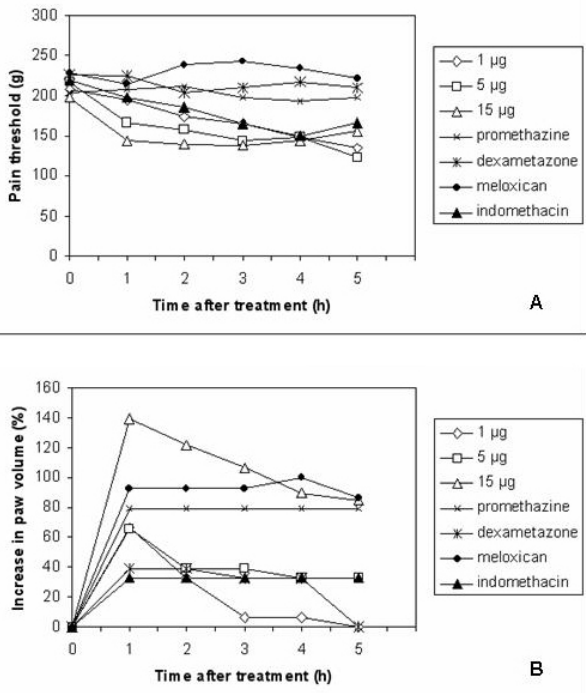
Figure 4. Evaluation of (A) hyperalgesic and (B) edematous activities of BmooMtx. Dose-dependent hyperalgesia and edema with BmooMtx doses varying from 1 to 15 μg/paw. The effect of meloxicam (2 mg/kg, i.pl., 20 minutes before), promethazine (5 mg/kg, i.pl., 30 minutes before), dexamethasone (0.4 mg/kg, i.pl., 60 minutes before) and indomethacin (4 mg/kg, i.pl., 30 minutes before) on the rat paw induced by BmooMtx (5 μg/paw). Hyperalgesia and edema were evaluated at 1, 2, 3, 4 and 5 hours after BmooMtx injection. BmooMtx or drugs were injected by intraplantar route. Sensitivity to pain was measured as the threshold response to pressure and expressed in grams. The volume increase (edema) was measured with the aid of a low-pressure pachymeter. The dose of 5 μg/paw was selected for experiments on pharmacological modulation. Results presented as mean of five